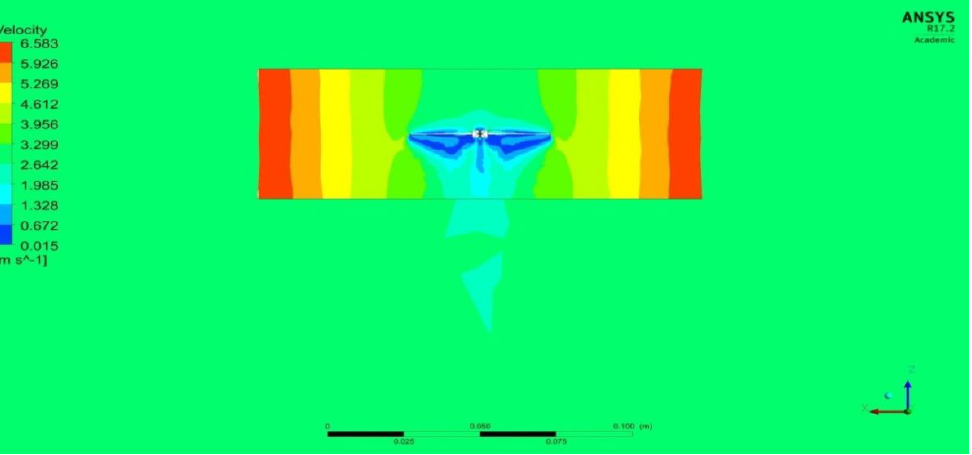
Figure 43. A typical planar view-based variations of velocity in and over the different frames.